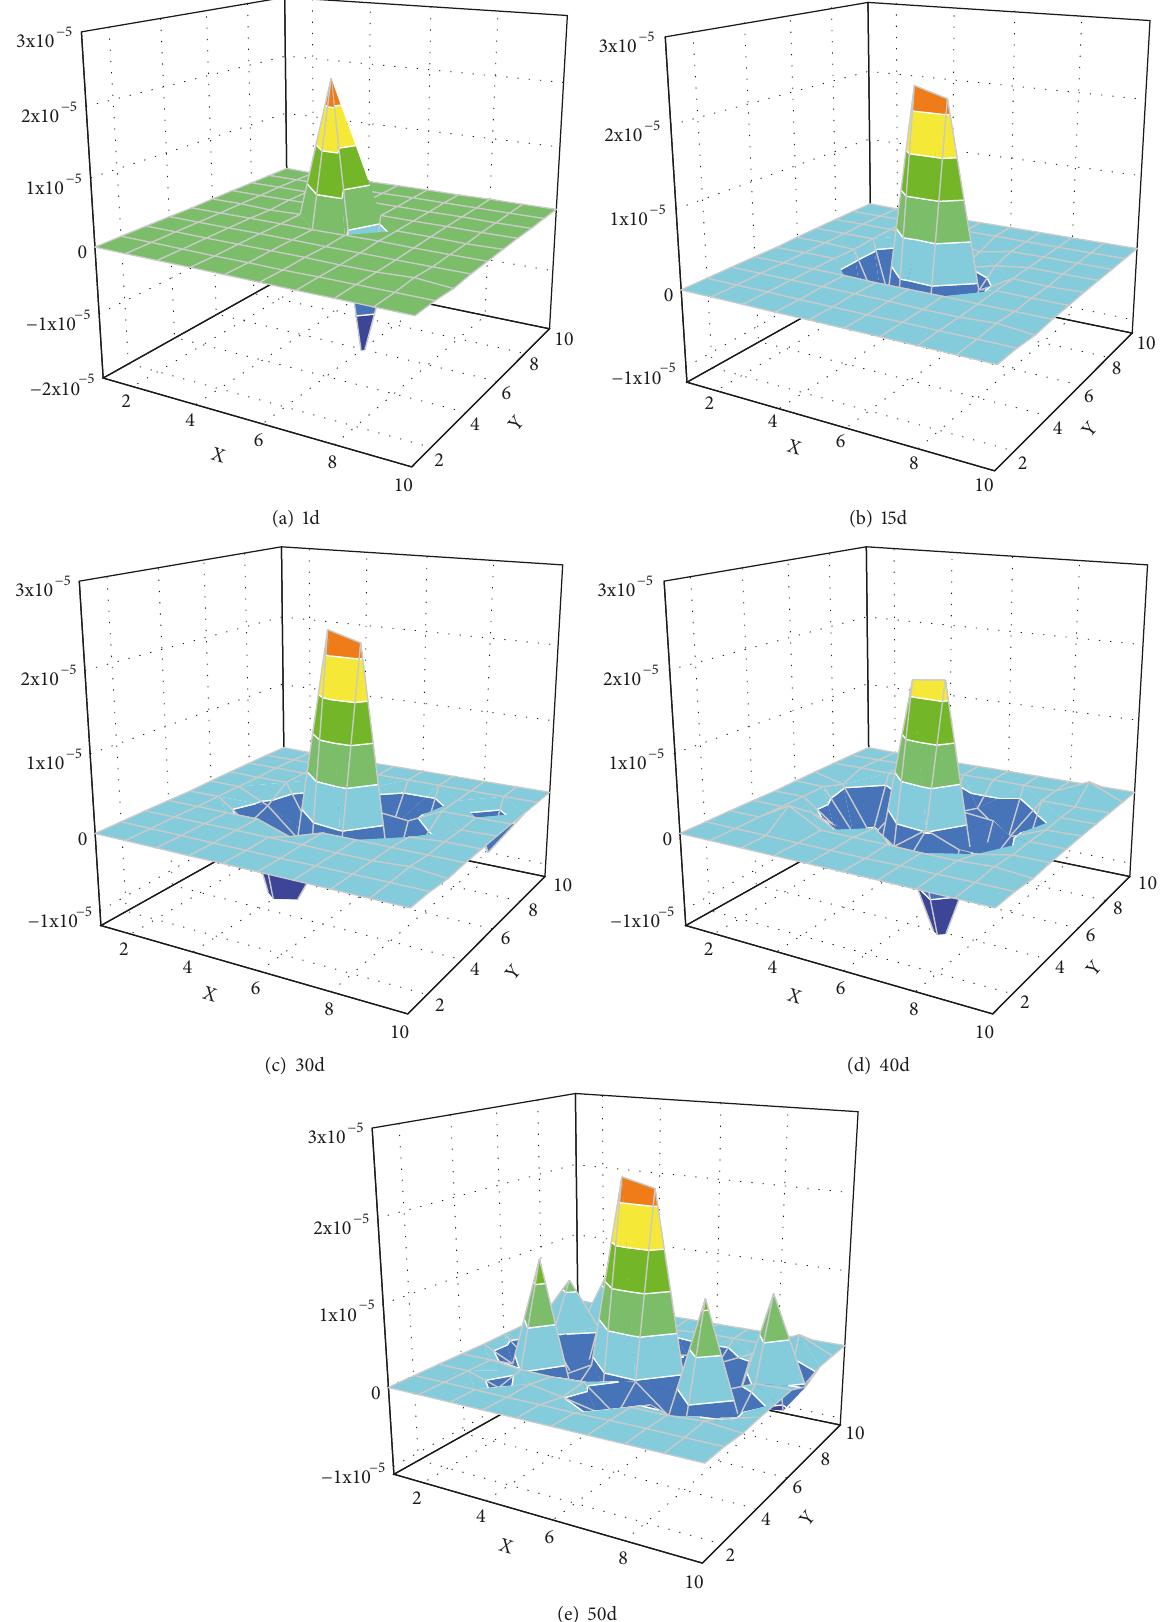
Figure 6: Current density distribution of scratch damage system immersed in 8.5%NaCl solution for different